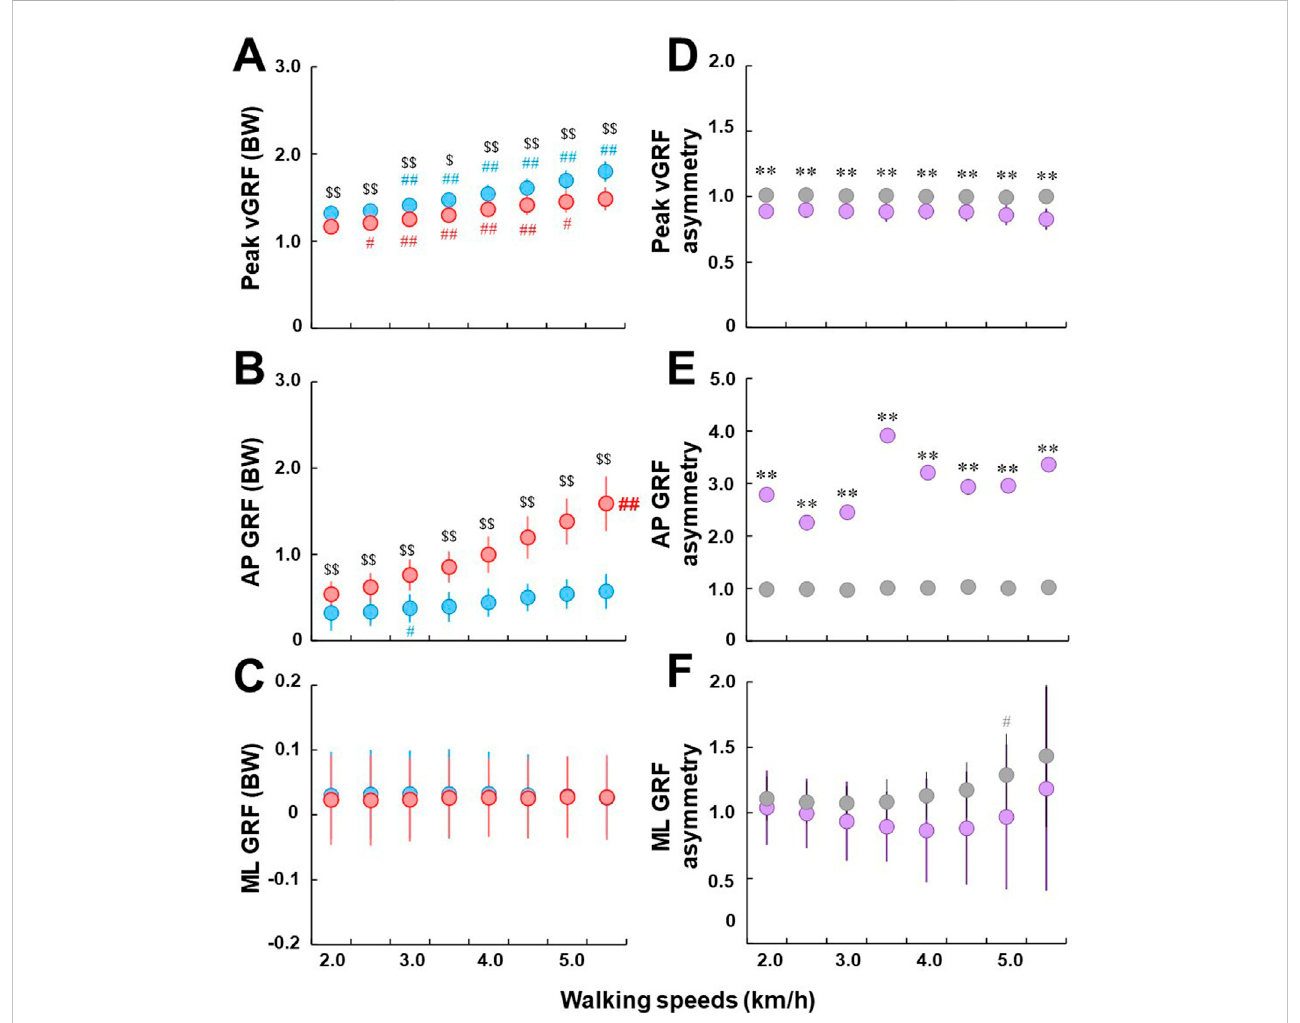
FIGURE 4 (A – C) : Comparisons of peak vGRF (A) , anteroposterior GRF (B) , and mediolateral GRF (C) between initial (blue) and terminal double limb stance (red), respectively. All GRF parameters were normalized to each participant ’ s body weight (BW). Circles and error bars indicate the mean value and the standard deviation in each DLS, respectively. For ML GRF, because lateral direction is opposite for each limb, absolute value was used. # and ## represent signi fi cant differences between the current and previous speeds at p < .05 and p < .01, respectively. $ and $$ represent signi fi cant differences between initial and terminal double limb stance at p < .05 and p < .01, respectively. Bold ## indicates a signi fi cant difference from adjacent speeds at all tested speeds at p < .01. (D – F) : comparisons of peak vGRF asymmetry (D) , AP GRF asymmetry (E) , and ML GRF asymmetry (F) between individuals with uTFA (purple) and the control group (gray). Circles and error barsindicate themean value and thestandard deviation ineach group, respectively. For theplot (E) ,standard deviations for the individuals with uTFA were omitted from the plot due to their large magnitude. * and ** represent signi fi cant differences in asymmetry ratio between the individuals with UTFA and control groups at p < .05 and .01,